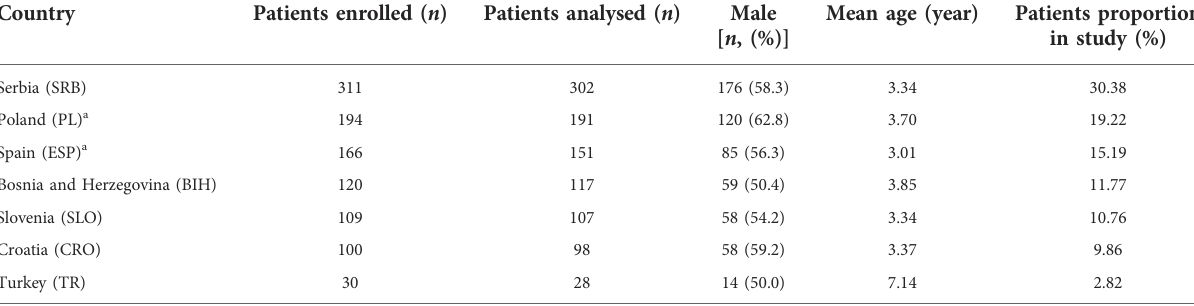
TABLE 1 General characteristics of the study population according to country.